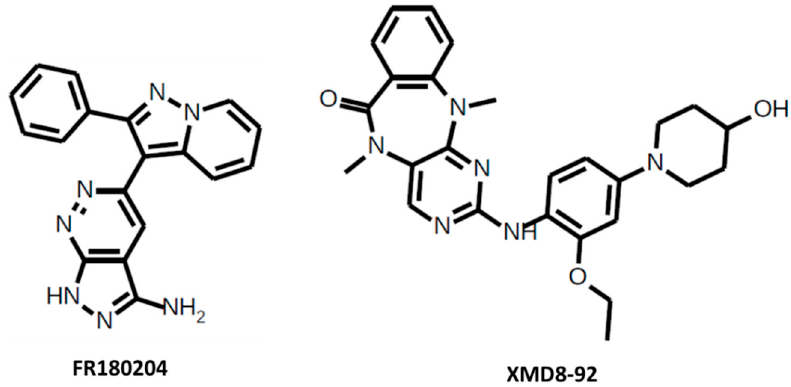
Figure 3. FR180204 and XMD8-92.